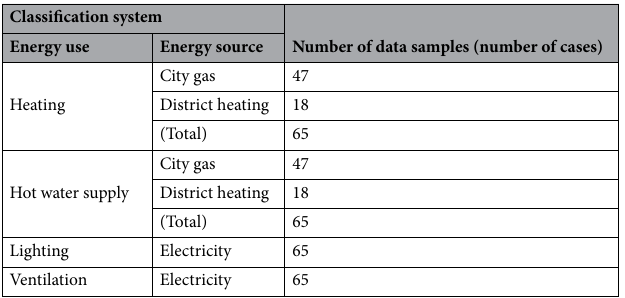
Table 1. Classification of BEEC assessment data by energy use and energy